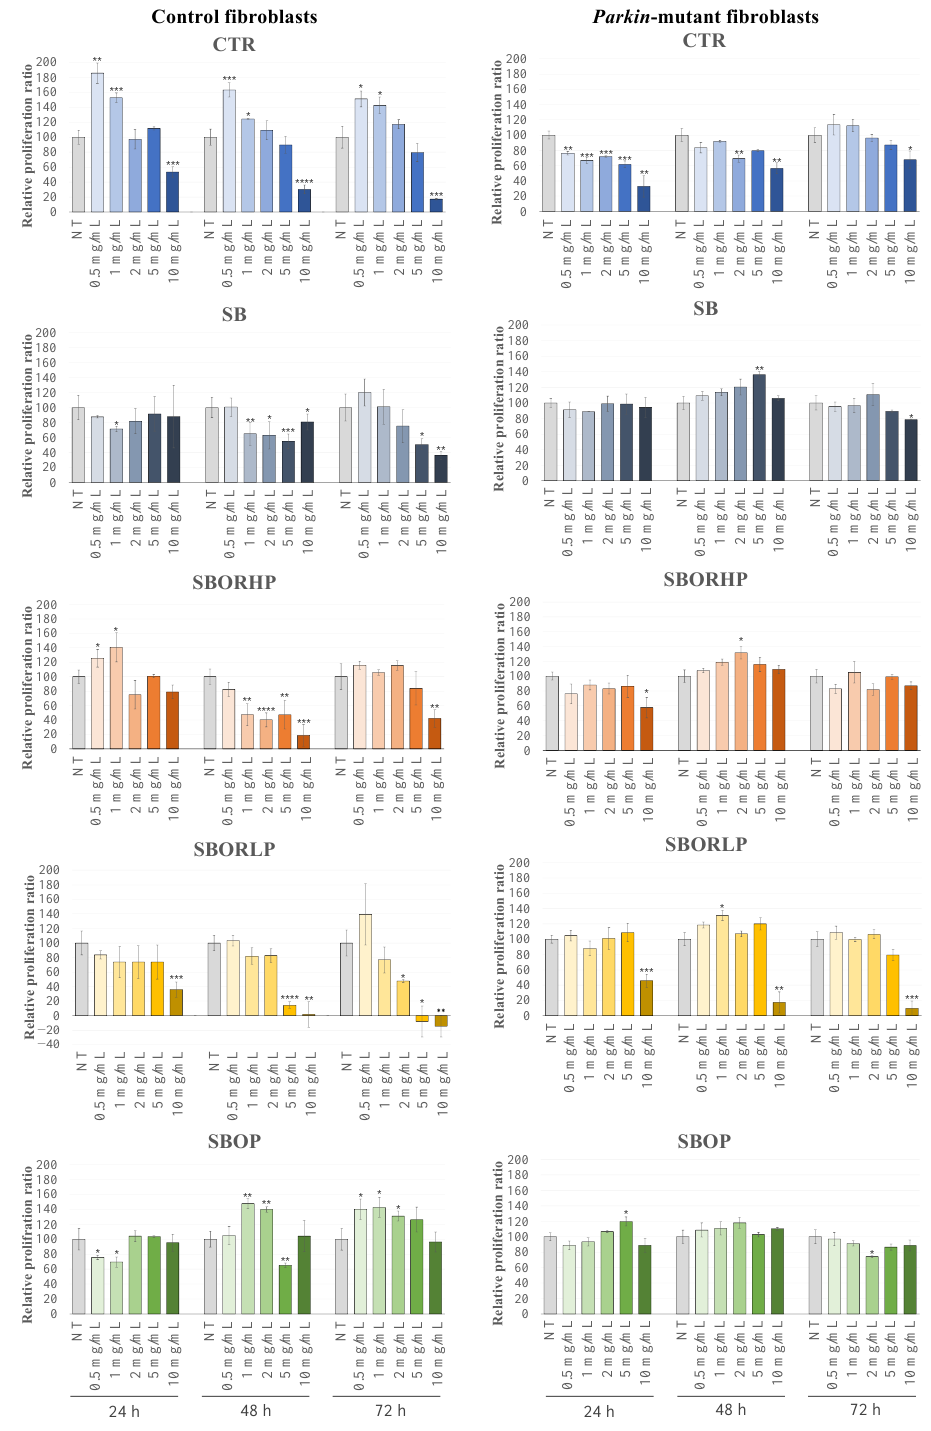
Figure 7. The MTT assay performed on the control and parkin -mutant fibroblasts. Cells were treated for 24 h, 48 h and 72 h with different samples of red onions at different concentrations ranging from 0.5 mg/mL to 10 mg/mL. Data were the means ± SEM from at least 3 independent experiments under each condition and were expressed as the percentage of vehicle-treated cells. Statistical analyses were performed using Brown-Forsythe and Welch one-way analysis of variance, and mean comparisons were made using the unpaired t - test with Welch’s correction. * p < 0.05, ** p < 0.01, *** p < 0.001, and **** p < 0.0001.